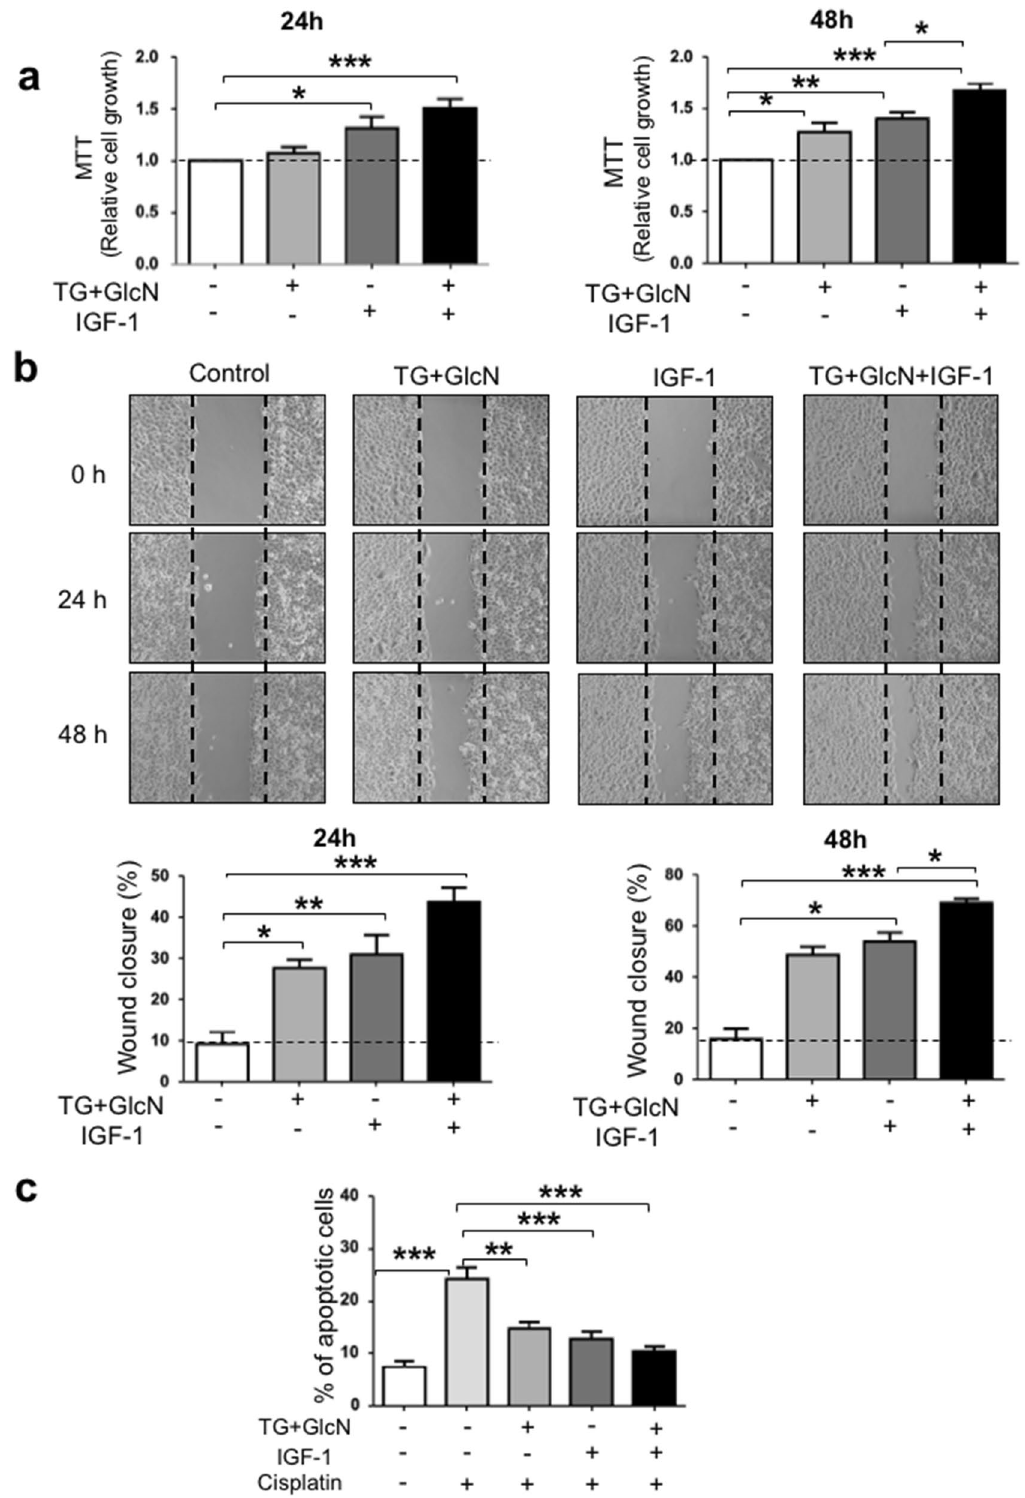
Figure 2. O -GlcNAcylation-inducing treatments increase cell growth and migration and inhibit apoptosis in CaSki cells. ( a ) Cells were cultured in 1% FBS and cultured in the absence and presence of O -GlcNAcylation-inducing agents (TG 10 µM and GlcN 5 mM) and IGF-1 (5 nM). MTT assay was used to determine the cell growth at 24 h and 48 h. Results are the mean ± SEM of 5 independent experiments. ( b ) Wound healing assay was performed as described in “Methods”. Representative images of the wound at 0, 24 and 48 h are shown. Migration is expressed as the wound closure percentage at 24 h and 48 h. The results are presented as mean ± SEM of 4 independent experiments. ( c ) CaSki cells were treated for 24 h with O -GlcNAcylation-inducing agents, IGF-1 and Cisplatin, and then stained with Annexin V and propidium iodide for FACS analysis. The results are presented as mean ± SEM of 4 independent experiments. Statistical analysis was performed using ANOVA followed by Tukey’s post-test. *, **, ***p < 0.05, p < 0.01 and p < 0.001,